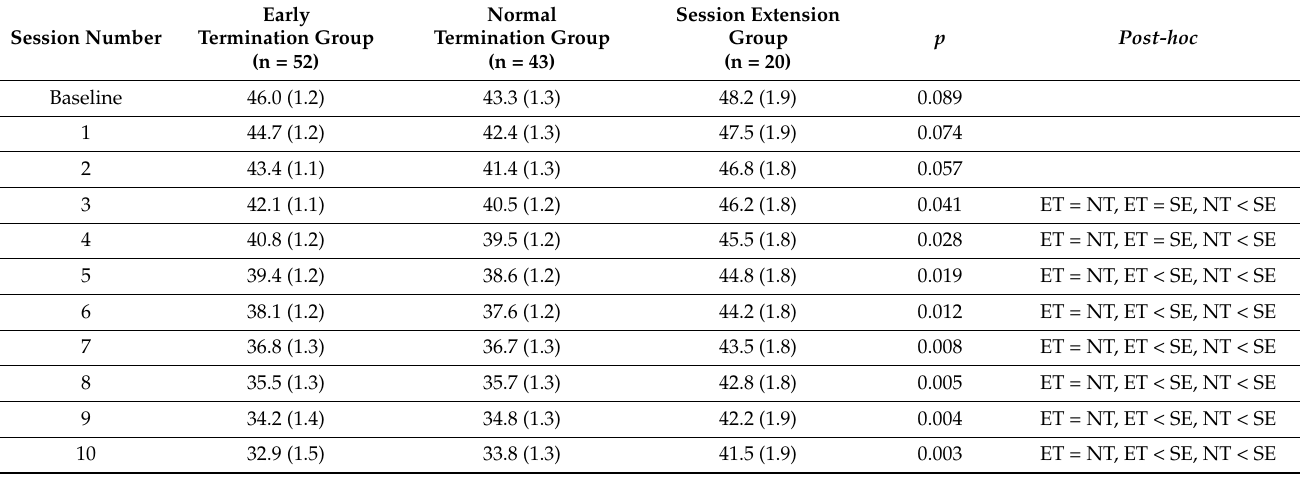
Table 2. Changes in the estimated mean of the Brief Fear of Negative Evaluation Scale scores according to session progress and group comparisons in each session.